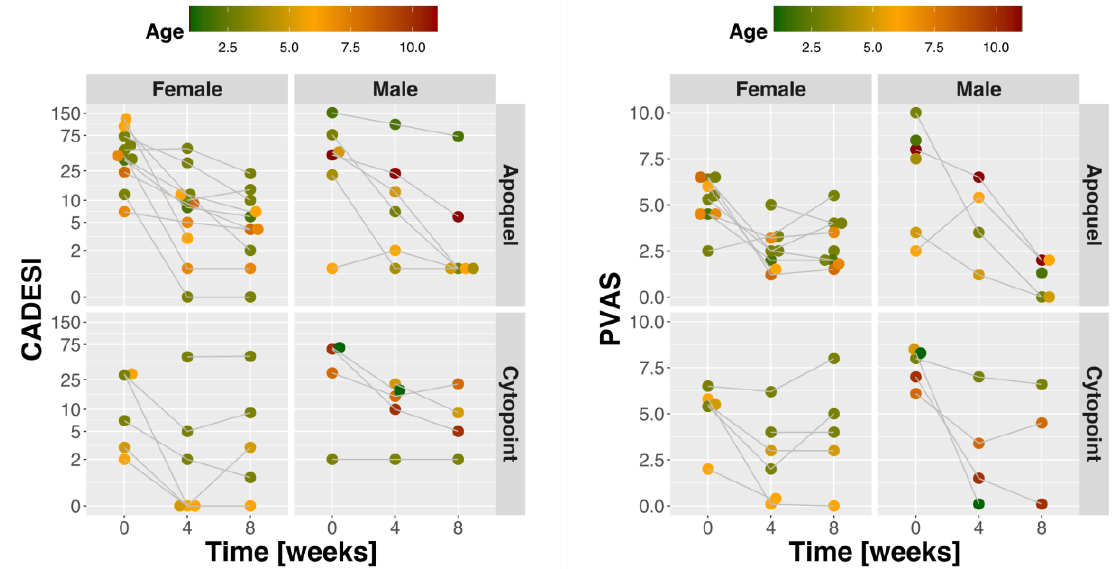
Figure 1. Changes in CADESI and PVAS scores during